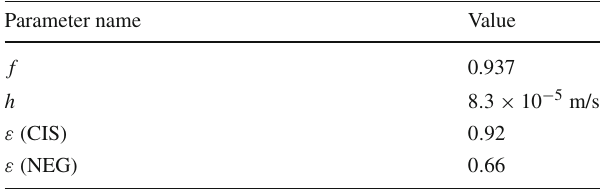
Table 1 Table of key parameters evaluated in the Xeclipse system: the coefficient of purity equilibration f , the convection mass transfer coefficient h , and the efficiency of O 2 removal ε for the two filters,